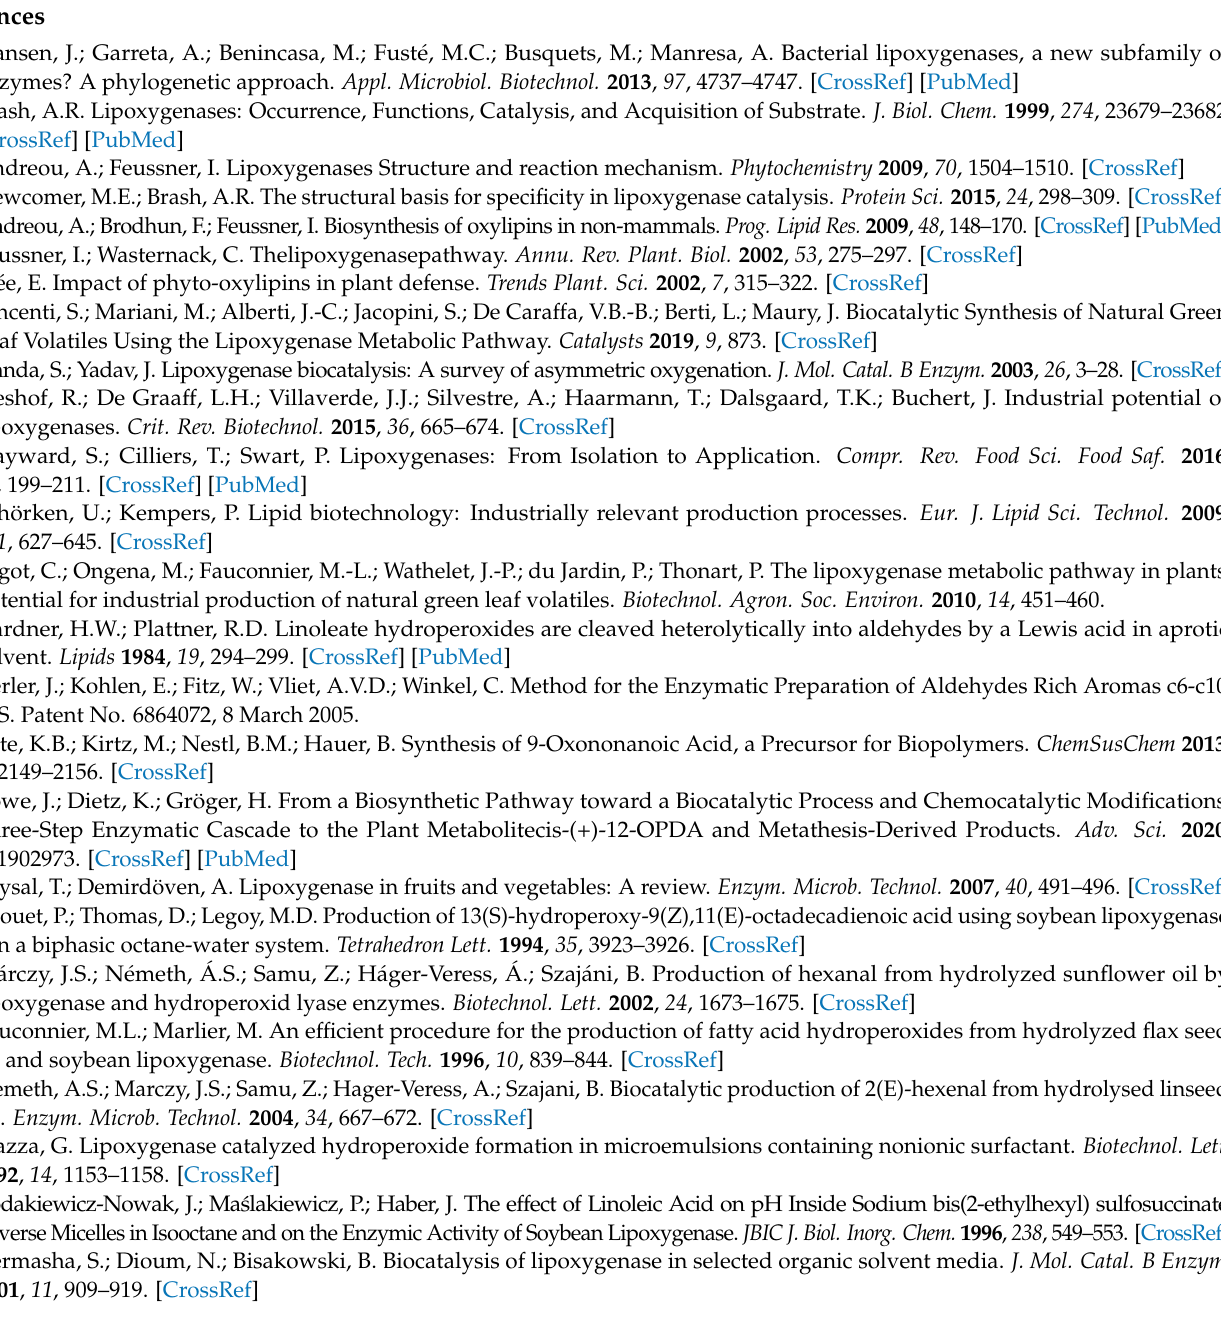
Figure S8: Comparison of linoleic acid and monolinolein hydroperoxidation, Figure S9: Comparison of HPODE yield with different LOX dosages. Figure S10: GC chromatograms of hydrogenated sam- ples from experiments shown in Figure 4a, Figure S11: Catalase concentration adjustment; Figure S12: GC-analysis of